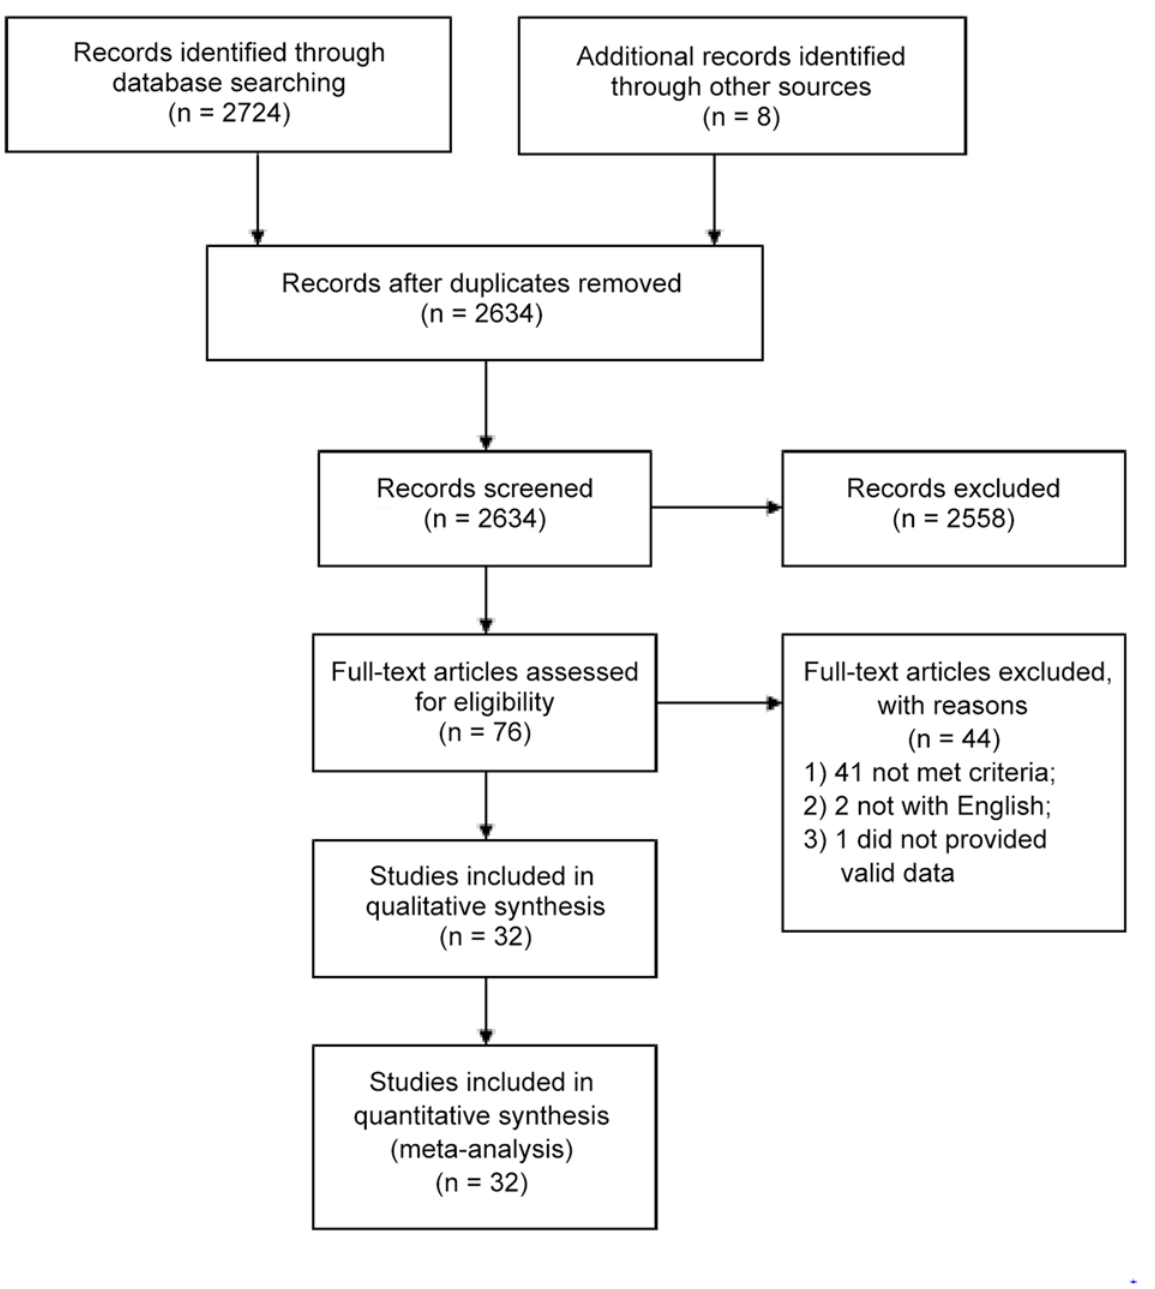
Fig 1. Flow diagram of the literature